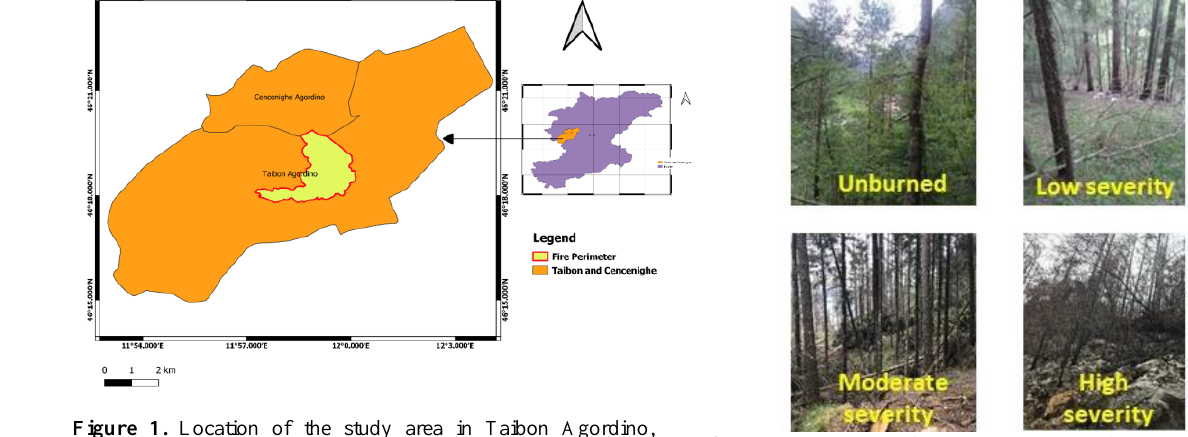
severity classes.